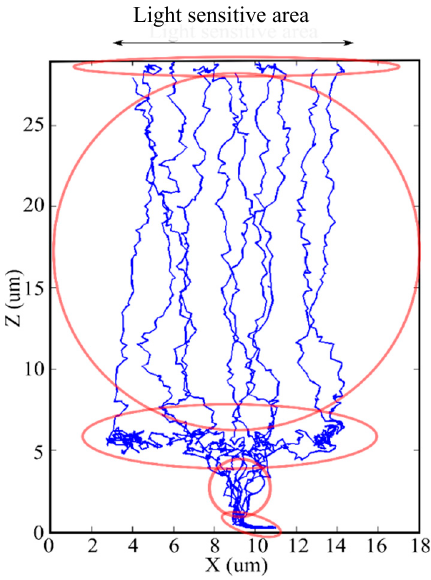
Figure 8. An example of trajectories of signal electrons for a pixel shown in Figure 1, which are simulated by Monte Carlo simulation.